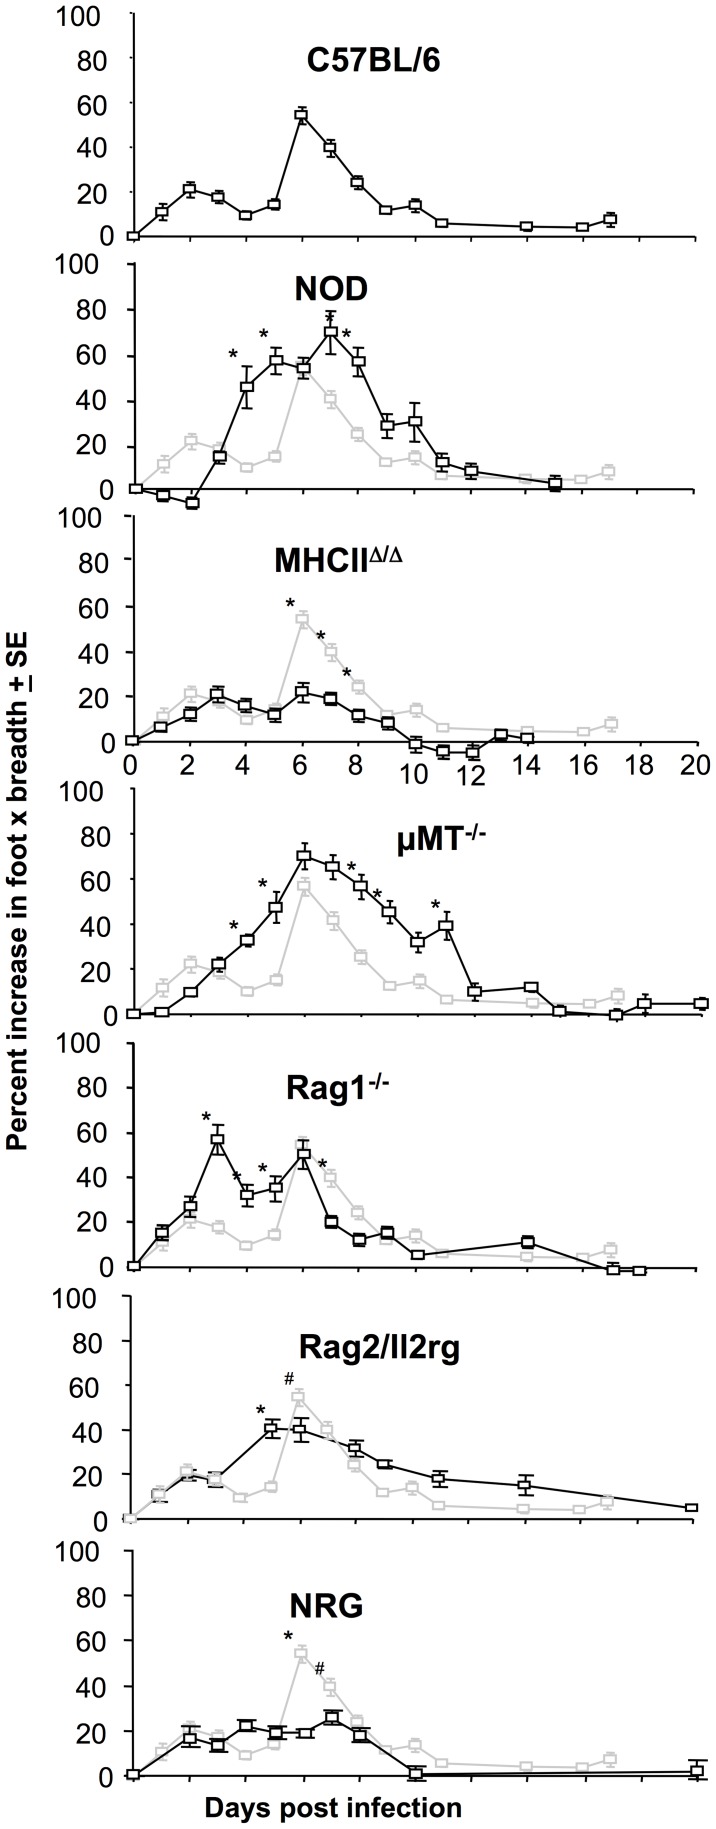
Foot swelling in different mouse strains.Foot swelling was determined in the same mouse strains shown in Fig. 1. C57BL6 (n = 18–28 feet, data from 6 independent experiments), NOD (n = 8), MHCIIΔ/Δ (n = 14–18, 2 independent experiments), µMT (n = 16–36, 4 independent experiments), Rag1−/− (n = 12–26, 3 independent experiments), Rag2/Il2rg (n = 8), NRG (n = 10). Significance by Mann Whitney U or Kolmogorov-Smirnov tests * p<0.008, # p<0.04. The light graphs show foot swelling in C57BL/6 mice for comparison.